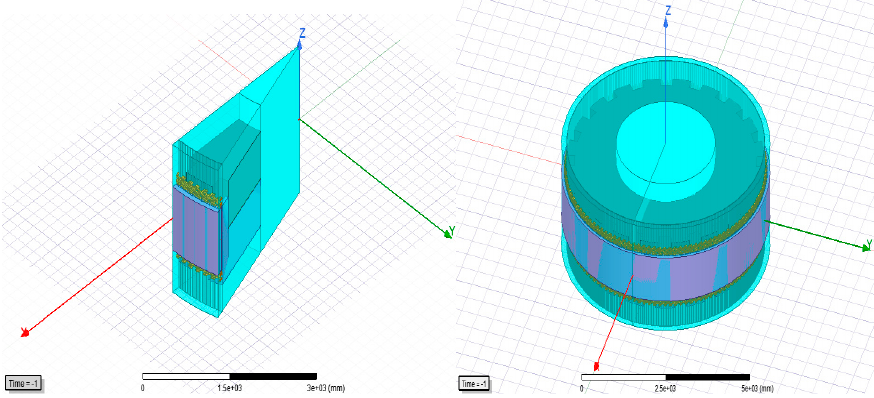
Figure 9. Modeling of the CPSM in Maxwell 3D Design.